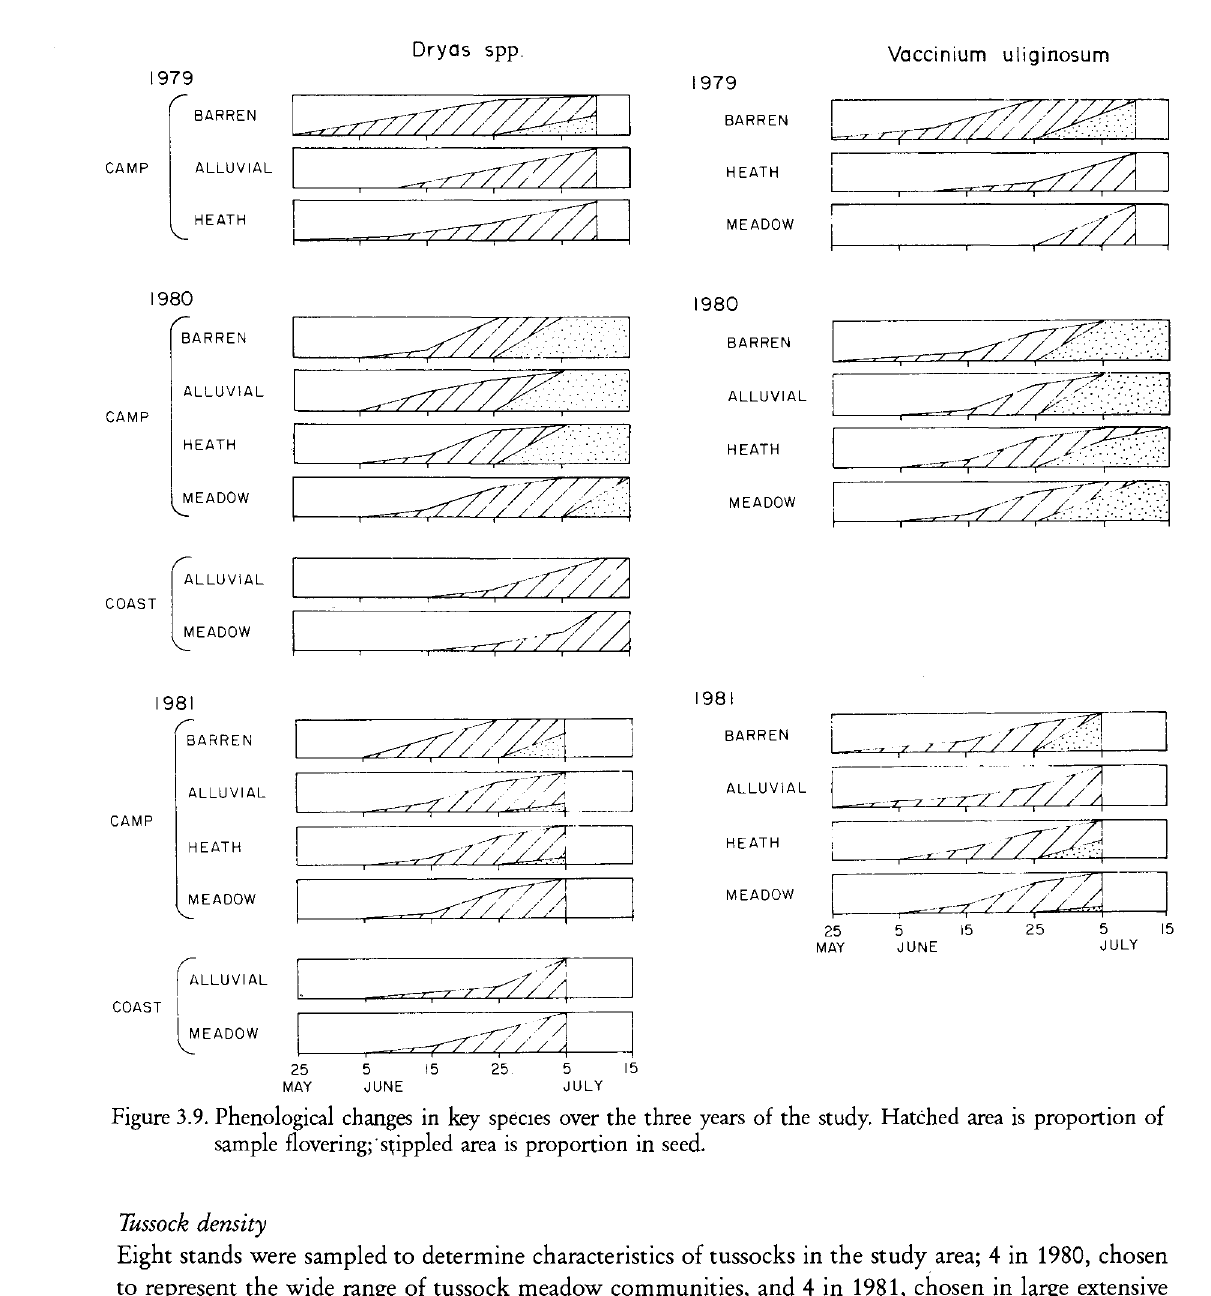
Figure 3.9. Phenological changes in key species over the three years of the study. Hatched area is proportion of sample flovering; suppled area is proportion in